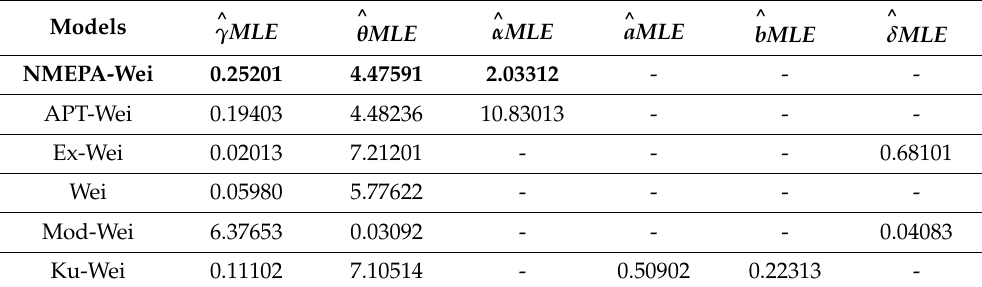
ˆ ˆ ˆ ˆ ˆ ˆ aMLE , bMLE , and θ MLE , δ MLE of the competitive models γ MLE , α MLE ,